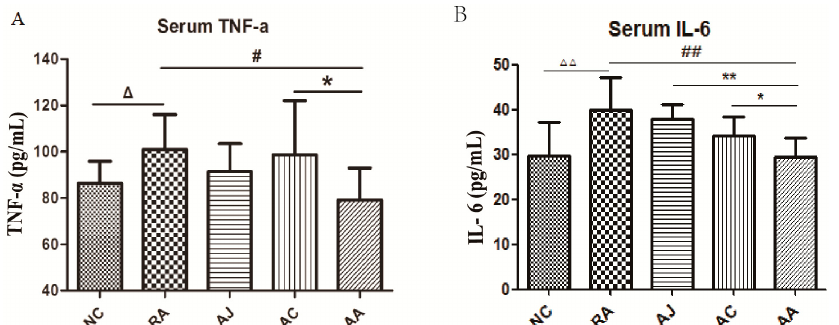
Figure 2. Effects of Aconitum carmichaeli , Ampelopsis japonica and their combination on serum TNF- α ( A ) and IL-6 ( B ) levels of the RA rat. Data is expressed as mean ± SEM ( n = 12). (NC, control group; RA, model group; AC, Aconitum carmichaeli -treated RA group; AJ, Ampelopsis japonica -treated RA group; AA, Aconitum carmichaeli + Ampelopsis japonica -treated RA group). △ p < 0.05 RA vs. NC; △△ p < 0.01 RA vs. NC; # p < 0.05 AA vs. RA: ## p < 0.01 AA vs. RA; * p < 0.05 AA vs .AC, ** p < 0.01 AA vs. AJ.